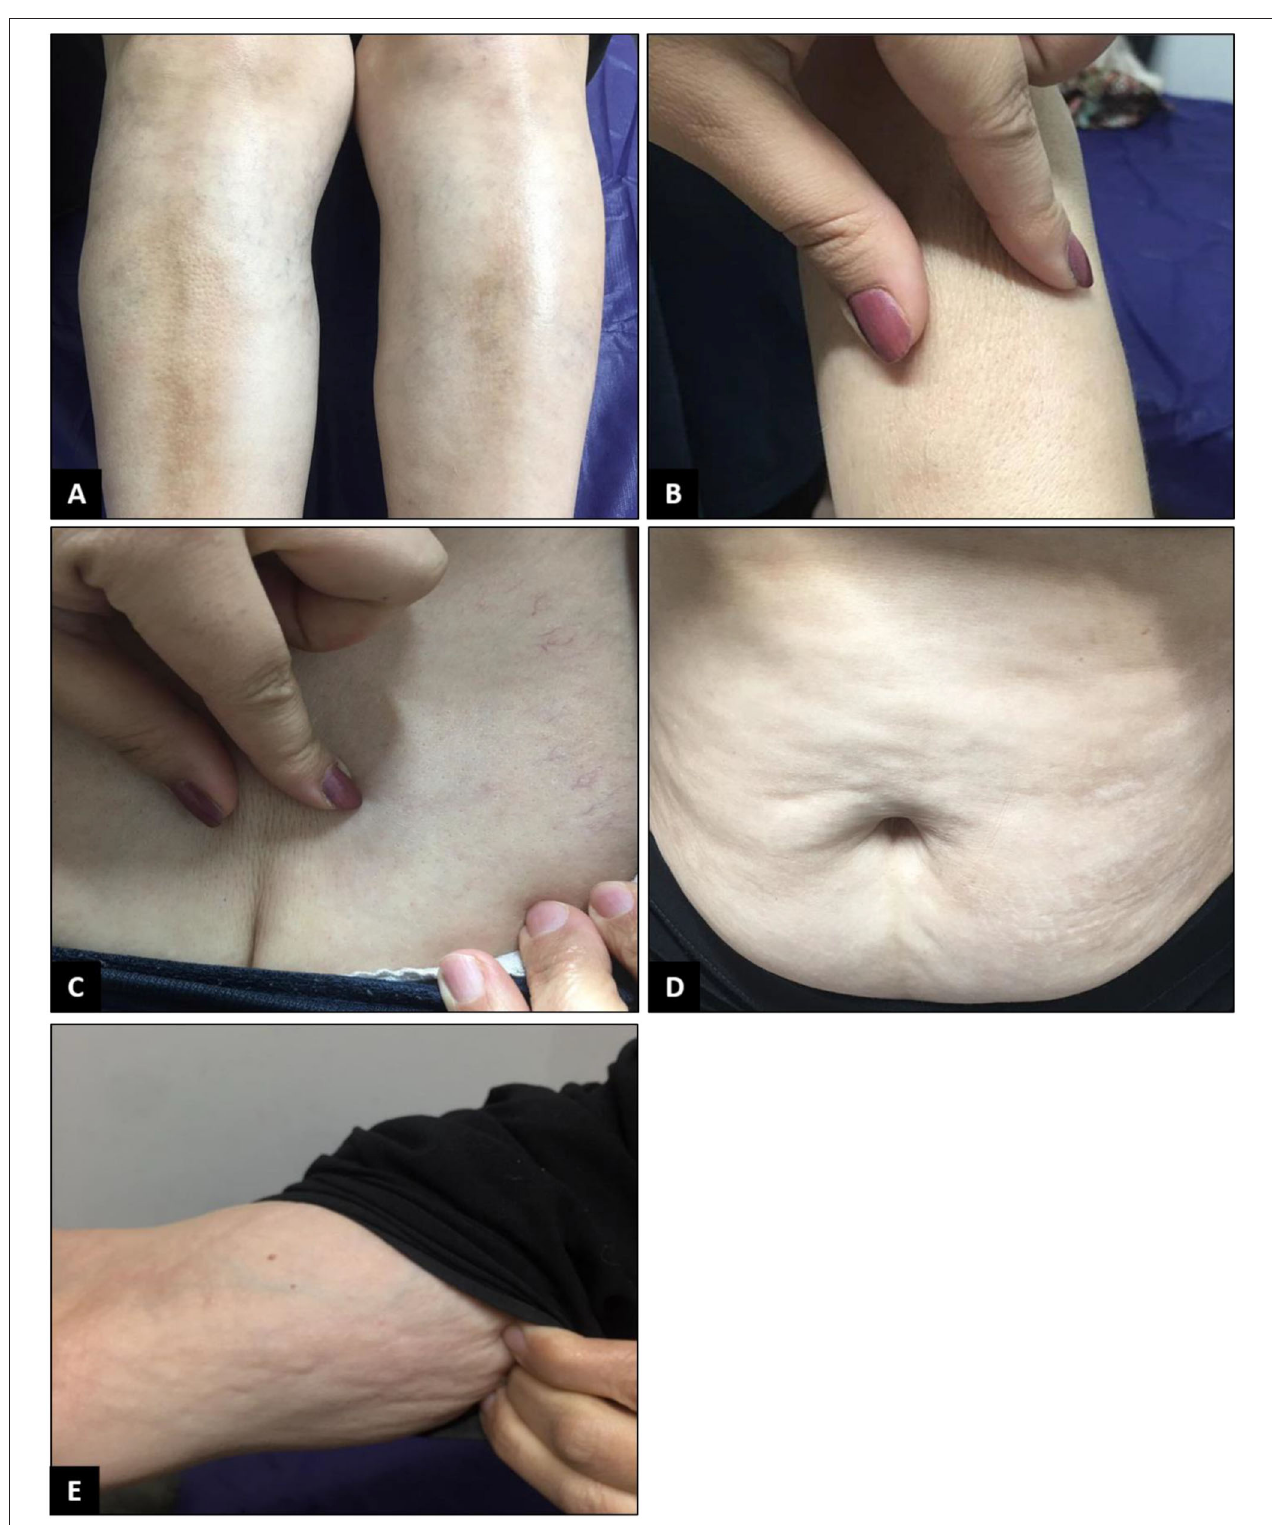
FIGURE 1 | Physical examination revealed the skin had turned shiny and tight. Severe sclerosis was detected on both pretibial regions (A) . When touched, the skin felt rather sclerotic and lost the ability to fold compared to normal skin (B,C) . Changes in the arm and lower abdomen in favor of morphea were also observed (D,E) .